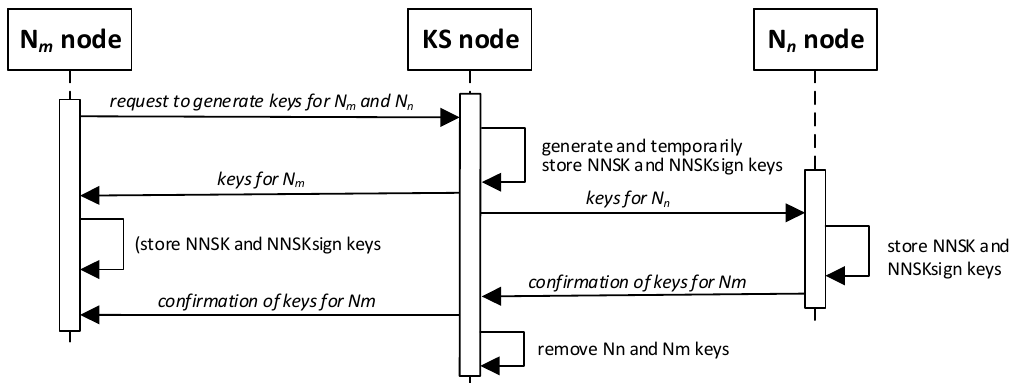
Figure 2. Sequence diagram of key generation for node pair N m and N n. Sensors 2020 , 20 , x FOR PEER REVIEW